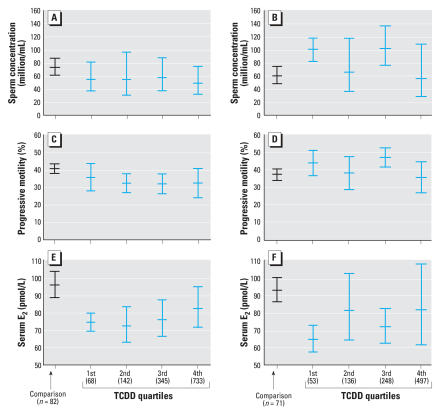
TCDD quartile distribution (adjusted mean and 95% confidence interval) of sperm concentration (A, B), total motile sperm count (C, D), and serum E2 (E, F) for exposed men and of same-age comparison groups [A,C,E; men who were 1–9 years of age in 1976 (22–31 years of age in 1998); B,D,F; men who were 10–17 years of age in 1976 (32–39 years of age in 1998). Median concentrations of TCDD quartiles (shown in parentheses) are expressed as parts per trillion on a serum lipid basis in 1976.